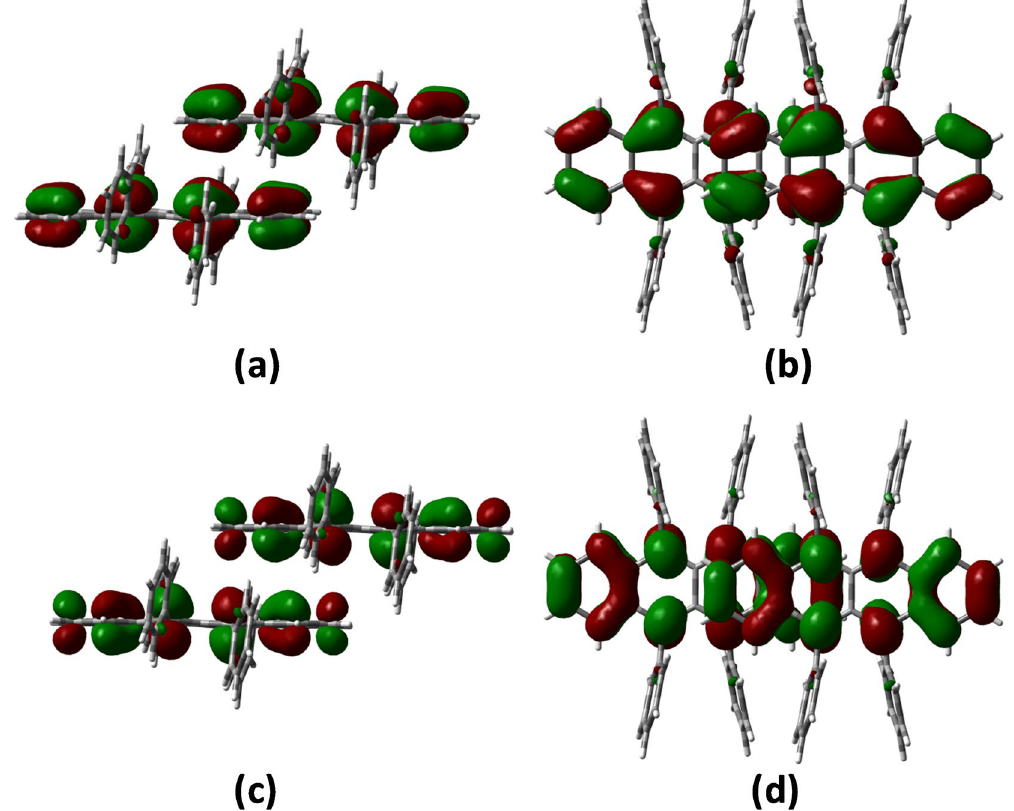
Figure 3. HOMOs (0.02 au) for P dimers of rubrene in side view ( a ), and in top view ( b ); and LUMOs (0.02 au) for P dimers of rubrene in side view ( c ), and in top view ( d